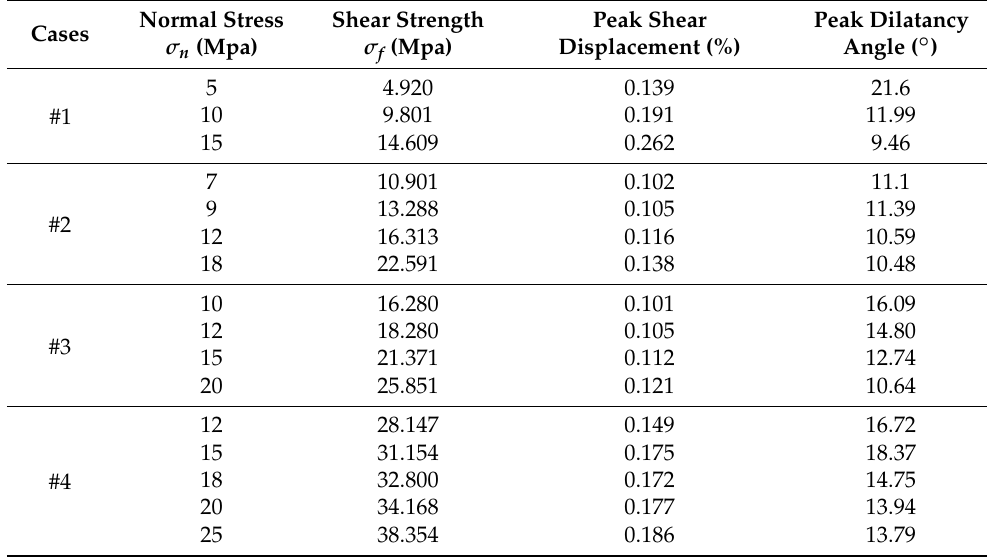
Table 4. The shear strength, peak shear displacement, and peak dilatancy angle under different cases.